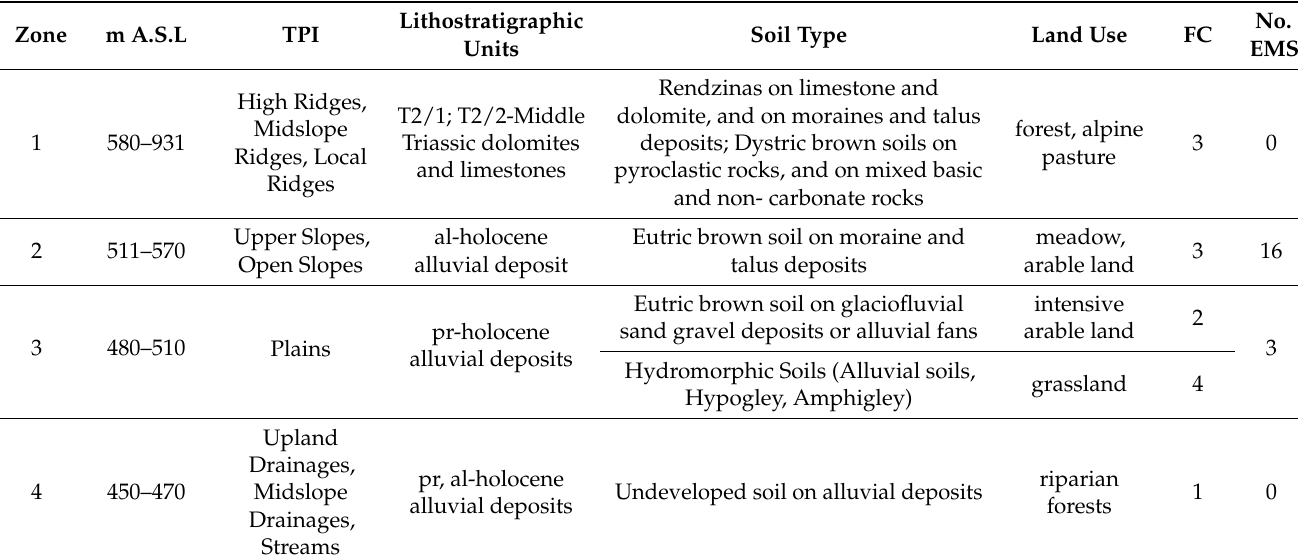
Table 4. A habitat descriptor for the defined zones within the Bled case study